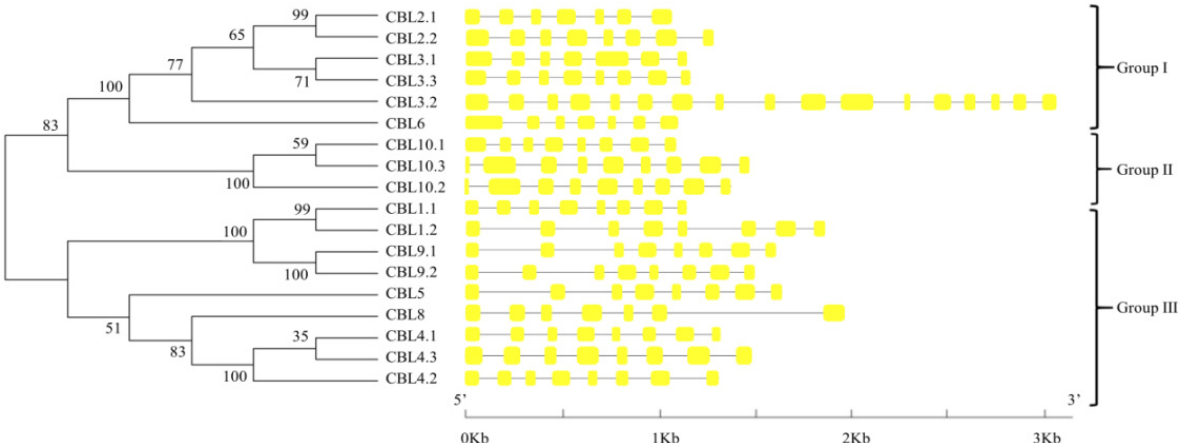
Figure 2. Phylogenetic relationship of Chinese Cabbage CBL proteins. The BraCBL protein sequences were aligned using the MAFFT version 7 program, and phylogenetic trees were constructed using the MEGA 7.0 software with the neighbor-joining method and the 1000 bootstrap test replicates. The tree can be divided into three major clades (Group I–Group III).